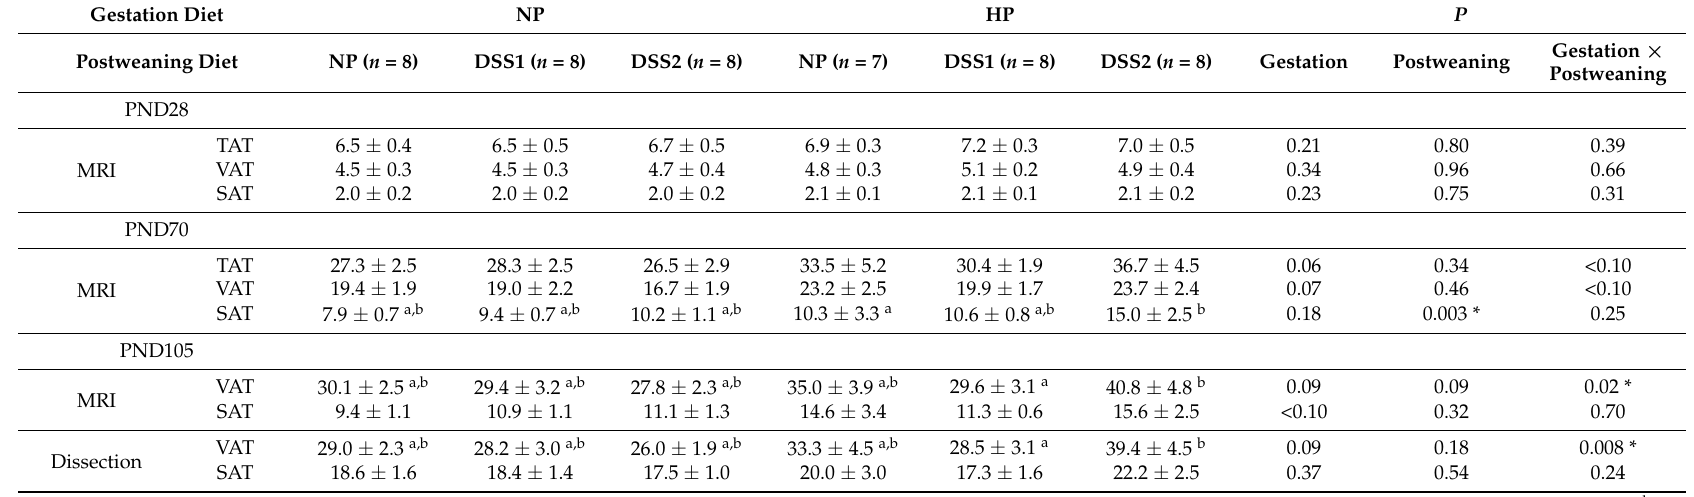
Table 2. Adipose tissue (total, visceral and subcutaneous) weights (g) on PND28, 70 and